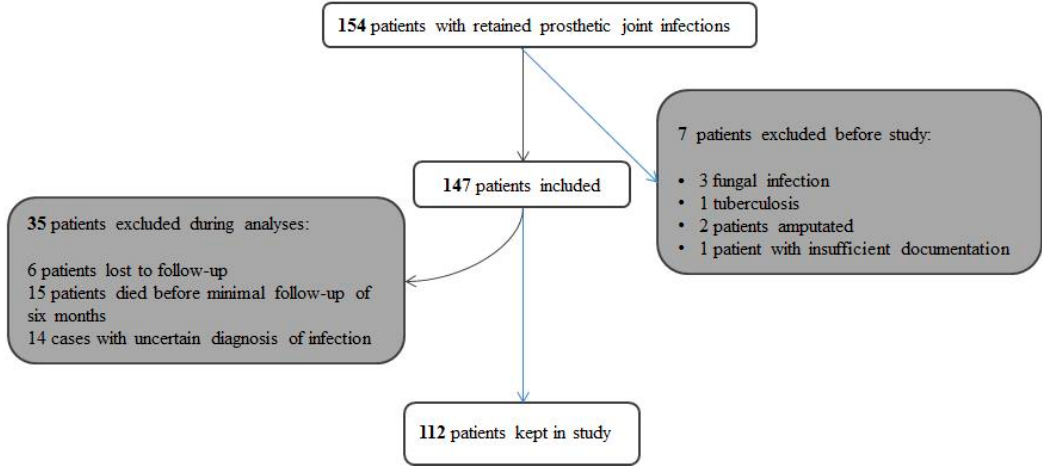
Figure 1. Flow chart displaying the inclusions and exclusions of our study.